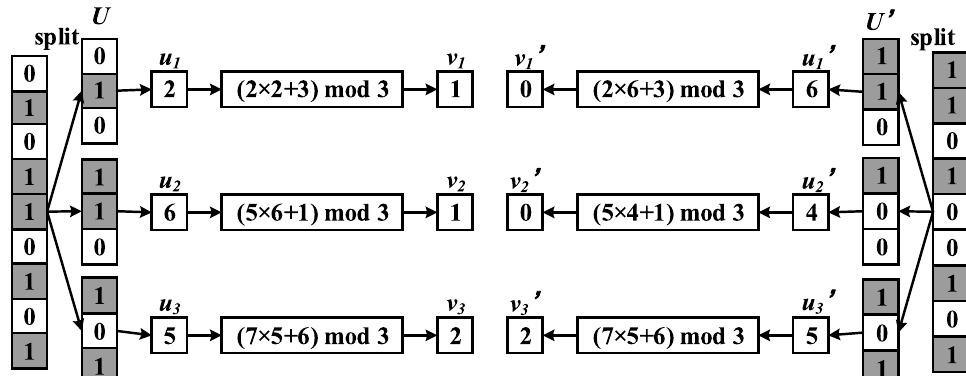
Fig. 3 An example of many-to-one mapping for two different Cosine LSH-based hashcode vectors. In the example, the left hashcode vector is { 0,1,0,1,1,0,1,0,1 } and U = {{ 0,1,0 } , { 1,1,0 } , { 1,0,1 }} . Then the integer set u = { 2,6,5 } is computed through U . The modulo function is set in the { 2,5,7 } , b ∈ B = { 3,1,6 } , | U i | = 3 , n = 2 , and M = 3 is the prime number closest to ⌊ 2 | U i | / n ⌋ . The format of ( a × u i + b ) mod M , where a ∈ A = { 1,1,2 } . Similarly, in the right side, we get the v ′ = { 0,0,2 } . From the result, we can observe that 2 appears result of the modulo operation is v i ∈ v = in both v and v ′ and with 1/2 probability to infer the u i or u ′ i correctly due to the modulo-based many-to-one mapping